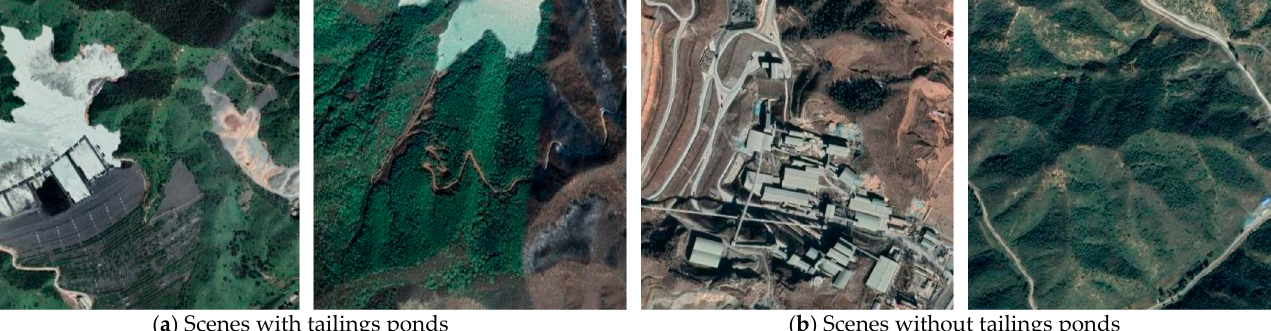
Figure 9. Example of the scene classification dataset of tailings ponds. ( a ) Remote sensing images with tailings ponds; ( b ) remote sensing images without tailings